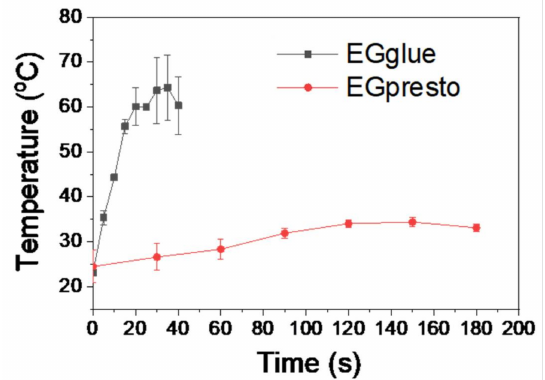
Figure 3. Temperature changes upon polymerizations of EGglue and EGpresto for measuring heat of polymerization and curing time. Temperatures from three independent measurements were averaged. The heat of polymerization for EGglue and EGpresto was measured to be 64 ± 7 ◦ C and 34 ± 1 ◦ C, respectively. The polymerization times were approximately 30 s and 120–150 s for EGglue and EGpresto,